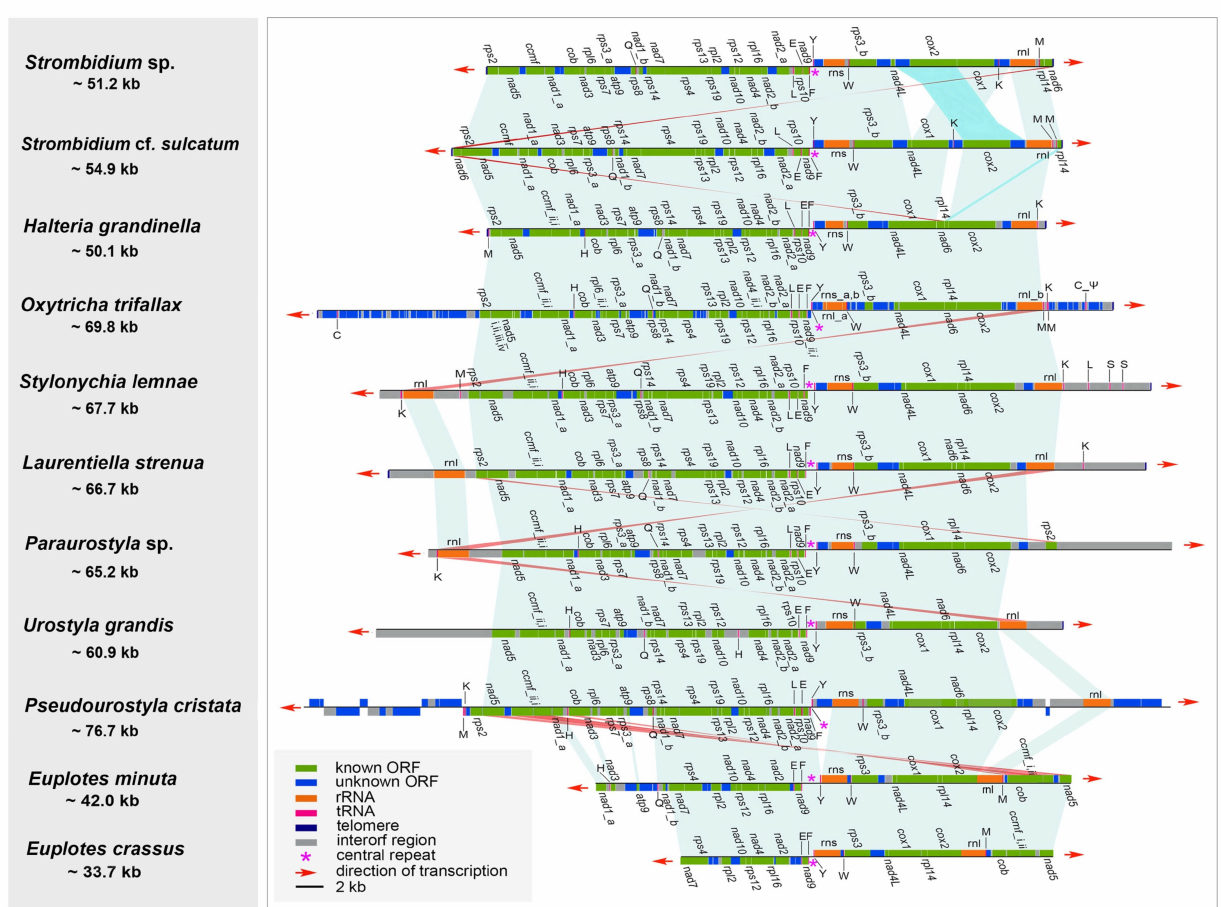
Figure 3. Mitogenome comparison of representatives within Spirotrichea (the subclass Oligotrichia: Strombidium sp., MT471315; Strombidium cf. sulcatum , MT471316; the subclass Hypotrichia: Halteria grandinella , MT471317; Oxytricha trifallax , JN383843; Stylonychia lemnae , KX524144; Laurentiella strenua , KX529838; Paraurostyla sp., KX524143; Urostyla grandis , KX494929; Pseudourostyla cristata , MH888186; the subclass Euplotia: Euplotes minuta , GQ903130; Euplotes crassus , GQ903130). Collinearity between the genomes is indicated by pale-green shades, while the structural rearrangements are indicated by pale-blue or pink shades. tRNA genes are represented by abbreviations of capital